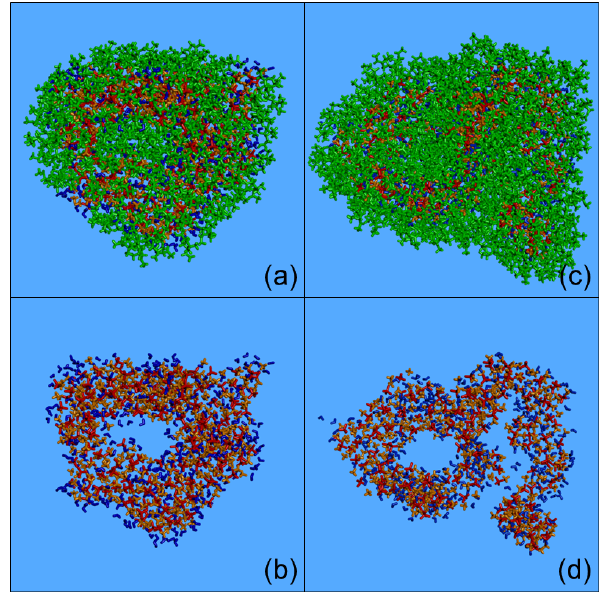
Figure 6. Characteristic snapshots from the MD simulations of the two nanoparticles at around 40% RH, containing CPA: (a) 58% (dry) including CPA molecules, (b) 58% (dry) omitting CPA molecules, (c) 74% (dry) including CPA molecules, and (d) 74% (dry) omitting CPA molecules. Colour coding: green for CPA, red for sulfate, orange for ammonium and blue for